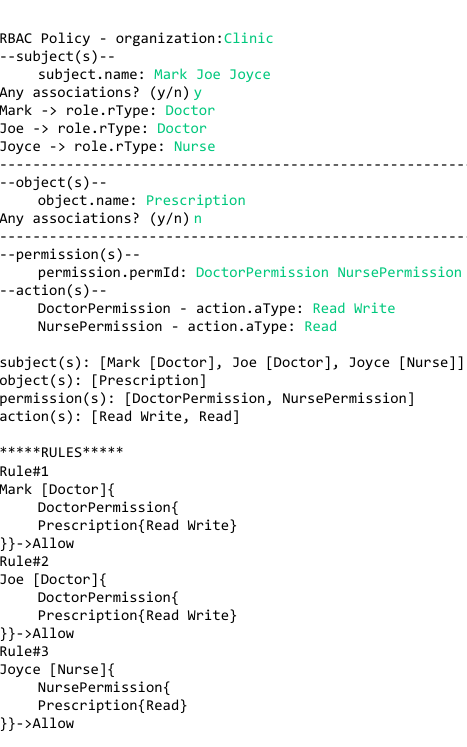
Figure 23. Example 1: generating RBAC